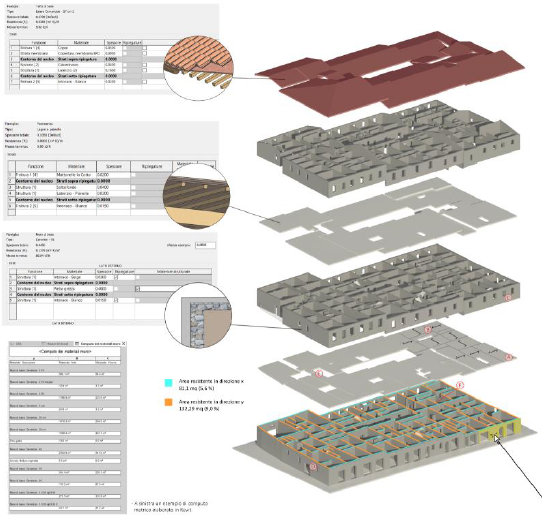
Figure 7. Digital information provided into the H-BIM at AL (Bonaguidi, 2019).